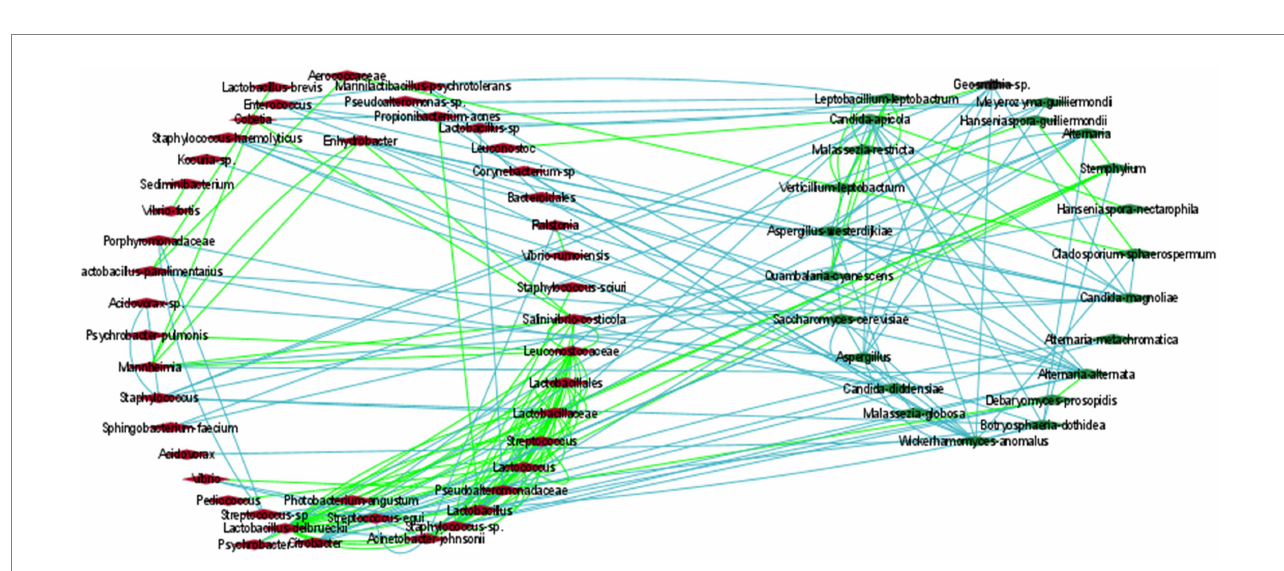
FIGURE 5 The correlation network of microbial communities in olives. Green and light-blue edges represent positive or negative correlations between two nodes, based on Spearman’s rank correlation, the Pearson correlation, and the Bray Curtis and Kullback–Leibler dissimilarity matrices. Red (left cycle) and green (right cycle) rhombus represent the bacterial and the fungal taxa,